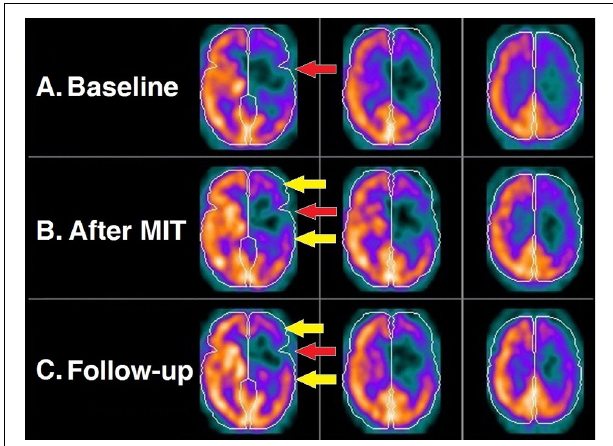
FIGURE 2 | Brain perfusion scintigraphy at the three time points of the study: before MIT (A) ; right after its completion (B) ; and 3 months later (C) . Each row depicts three consecutive transversal SPECT slices of the brain. Perceptible radiotracer uptake (warm colors) represents cortical areas with normal blood supply, as opposed to those exhibiting diminished to negligible uptake (cold colors) denoting mildly to severely compromised perfusion. Expectedly, the necrotic core of the stroke ( red arrow ) remains unaltered in all three scans. However, there is an evident gradual perfusion improvement of the hypoperfused cortex surrounding the necrotic core ( yellow arrows ).